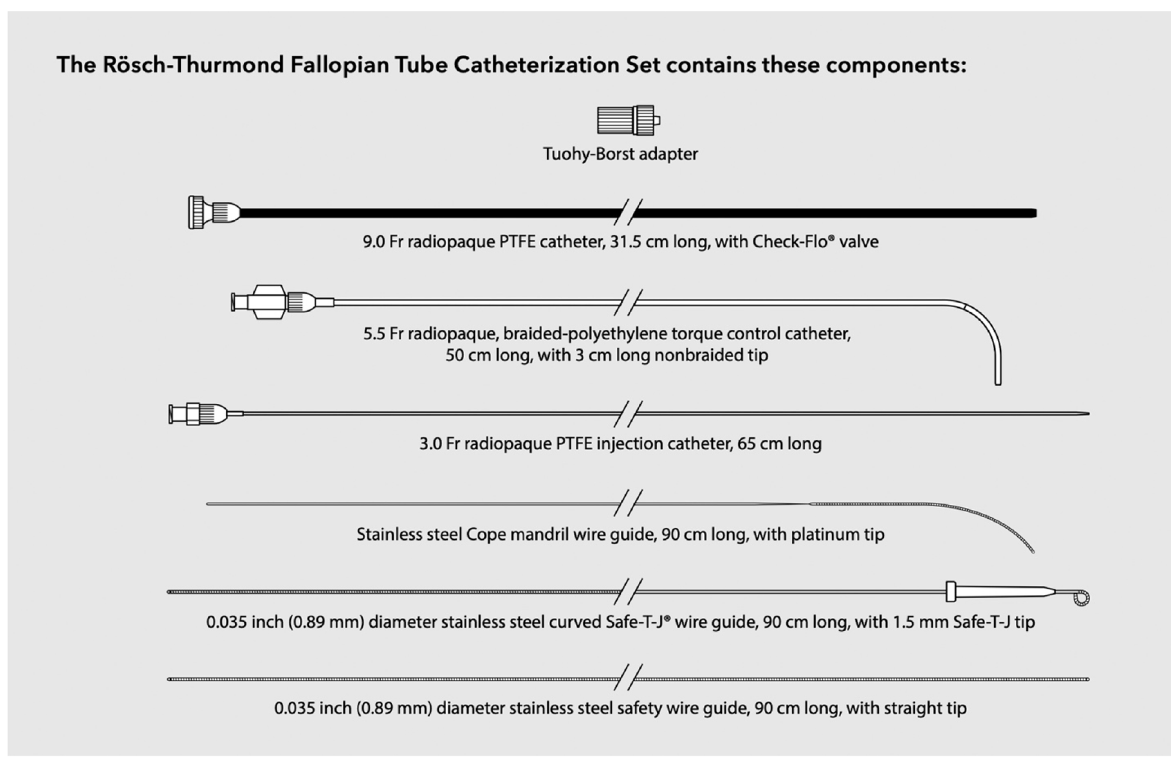
Fig. 2 The components of the Rosch-Thurmond Fallopian Tube Catheterization Set (Cook Inc. Bloomington, IL). https:// www. cookm edical. com/ data/ resou rces/ RH- D56218- EN-F_ M3_ 15946 61982 191.